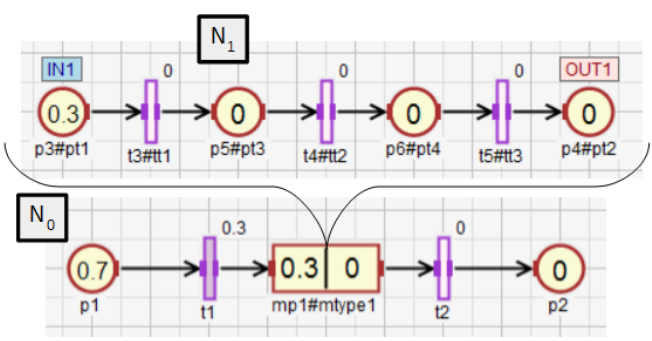
Figure 10. HFIPN with the single macroplace mp 1